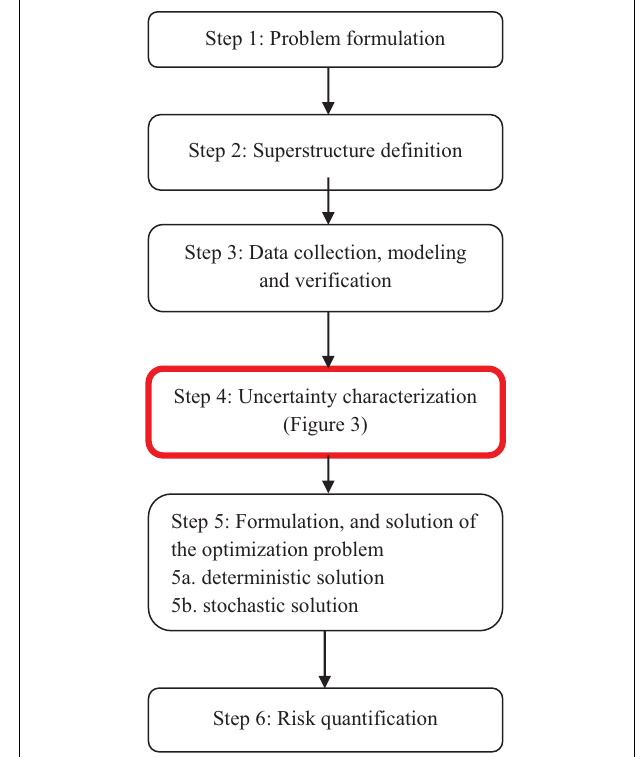
FIGURE 3 |The highlighted step (Step 4) is expanded as presented in the methodology section (see Materials and Methods) .